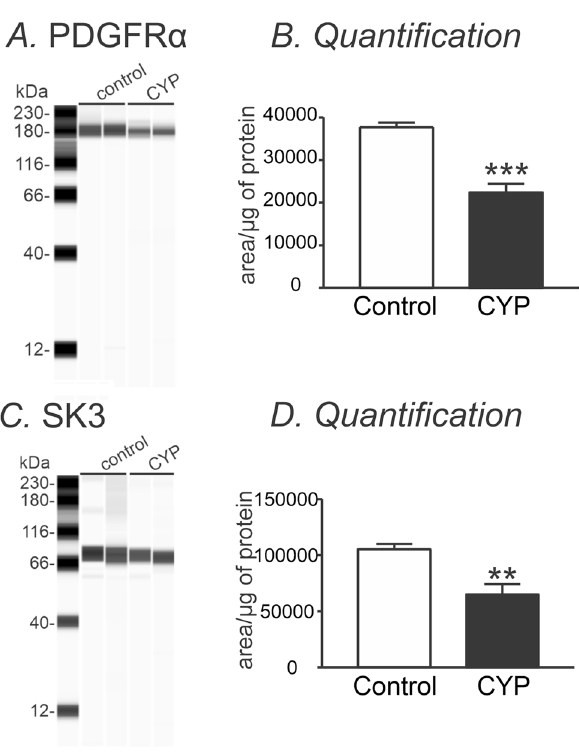
Figure 3. Expression levels of PDGFRα and SK3 in control and CYP-treated detrusor muscles. ( A,C ) Representative gels of PDGFRα ( A ) and SK3 ( C ) expression in control and CYP-treated detrusor muscle [Original Wes image blots for PDGFRα and SK3 (Supplementary Material)]. ( B,D ) Quantification analysis of expression level of PDGFRα ( B ) and SK3 ( D ) in control and CYP-treated detrusor muscle. **Denotes P < 0.005, ***denotes P <